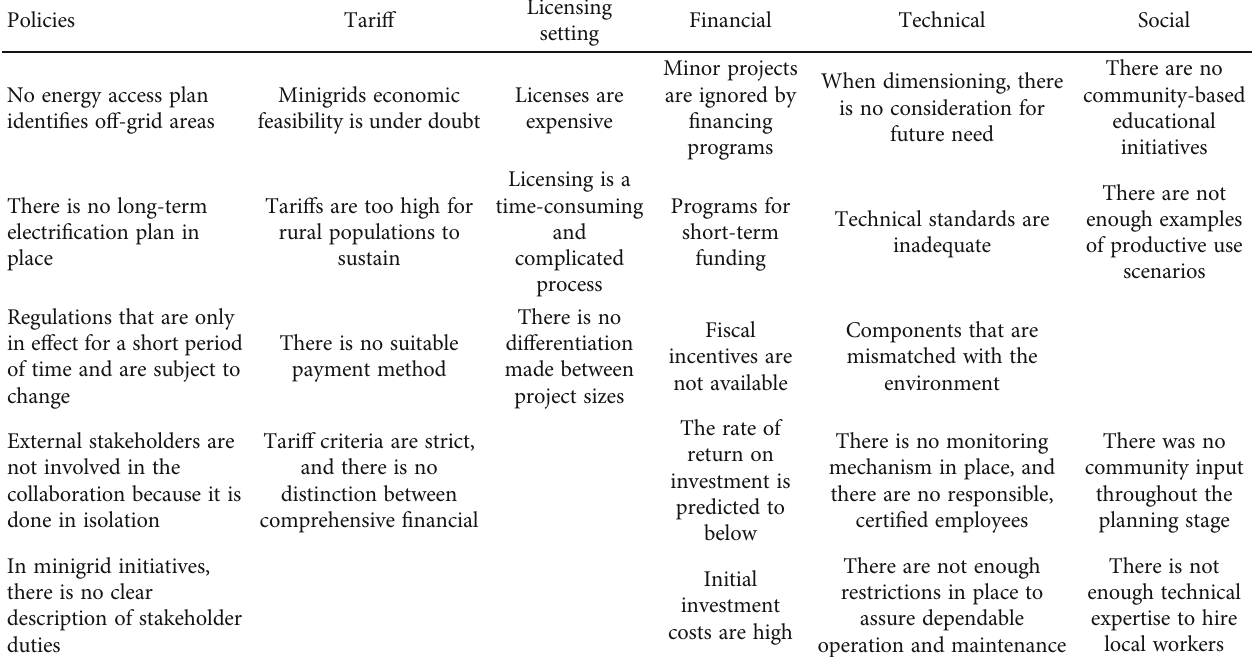
Table 6: Challenges of o ff -grid electri fi cation in a